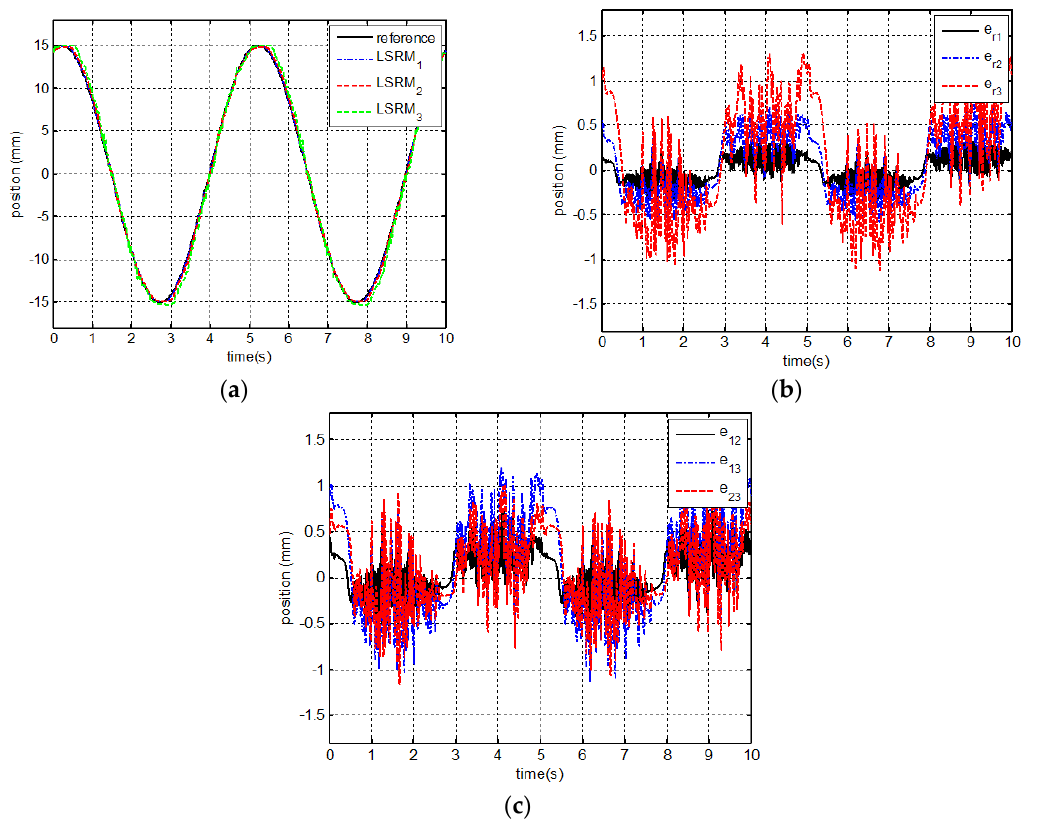
Figure 10. Tracking profiles: ( a ) LSRMs; ( b ) error to reference; and ( c ) relative error response under leader–follower–observer feedback with IMC.